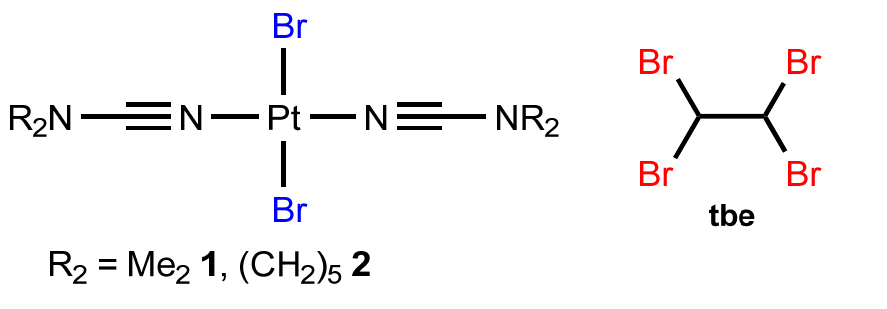
Figure 1. Studied XB partners.